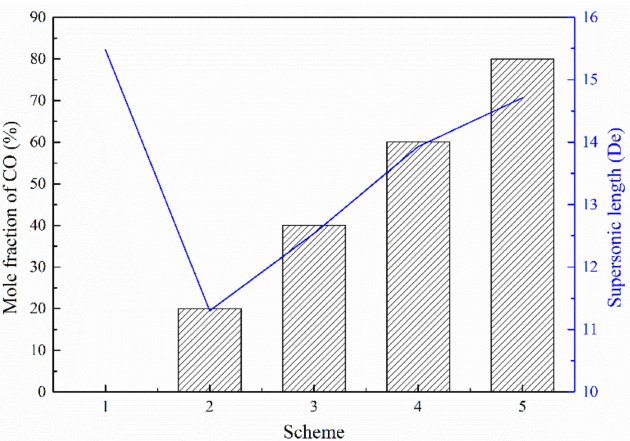
Figure 9. Supersonic length of the Laval